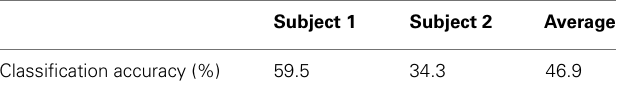
Table 1 | Classification accuracy (%) achieved by using the voting of linear SVM and LDA classifiers on the test dataset for two